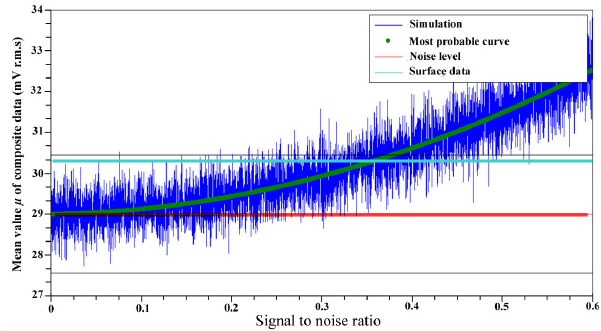
Fig. 11. Distribution of the standard deviation σ of the composite bin 36 versus SNR. The most likely value (SNR ∼ 0.225) lies at the intersection between the green curve and the bright blue line as in Fig. 10. Black lines at 7.3 and 9.3mV are min and max values, respectively, of noise amplitude in the absence of